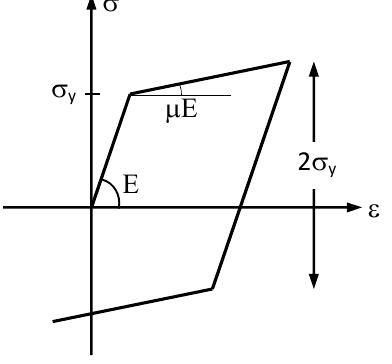
Fig. 4. Stress-Strain behavior of bilinear kinematic hardening model for Bauschinger effect.